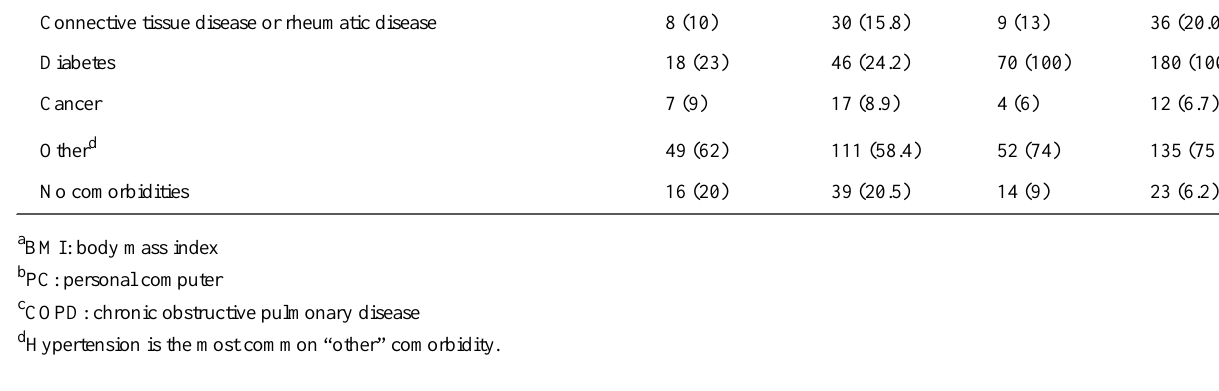
Table 2. The baseline, postintervention, and change scores in the eight dimensions of the health-related quality-of-life assessments and in the two summary scores for heart disease patients.